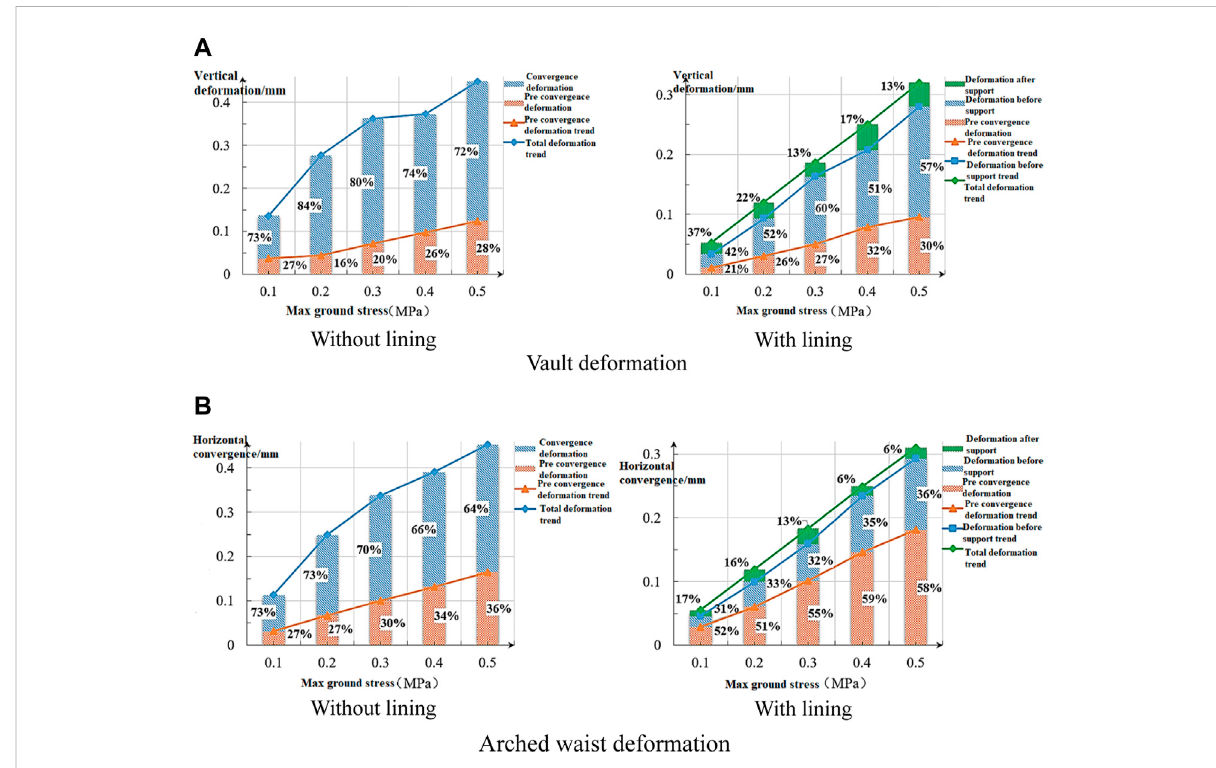
FIGURE 12 Deformation trend of the vault and arched waist under different stress states. (A) Vault deformation; (B) arched waist